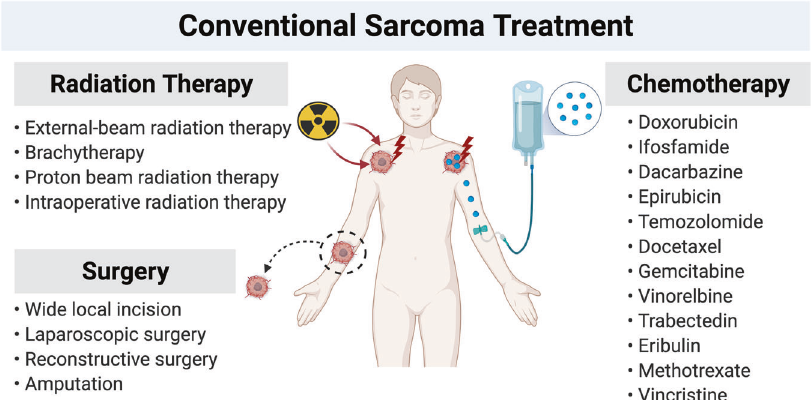
Fig. 2 Schematic illustration of conventional sarcoma treatment